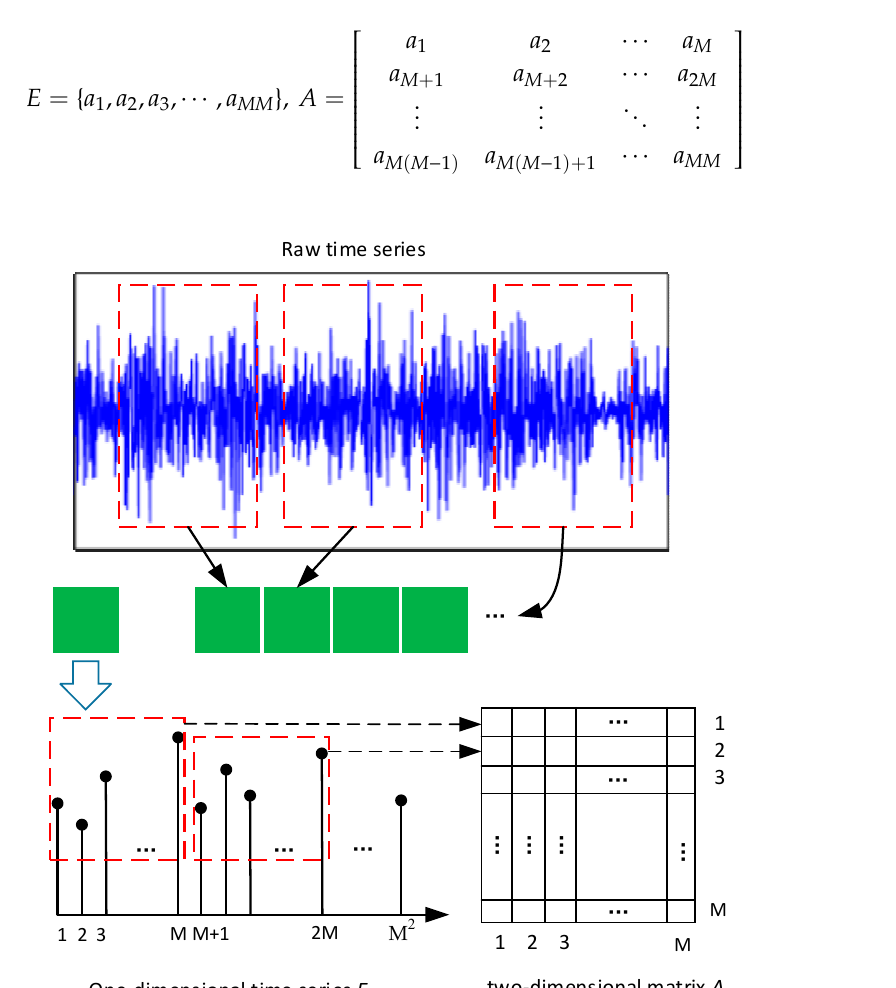
Figure 5. The matrix construction process.